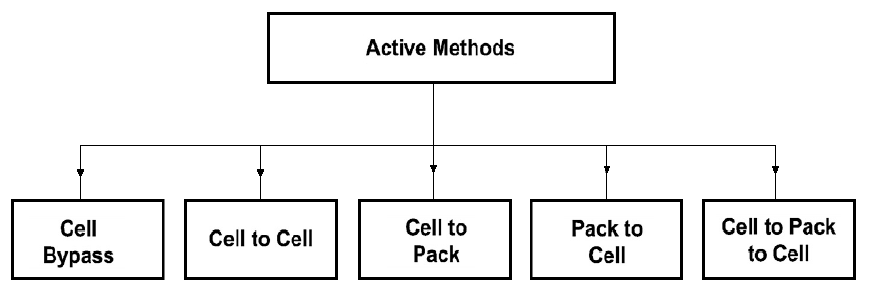
Figure 2. Classification of the active balancing methods depending on the method of energy transfer.